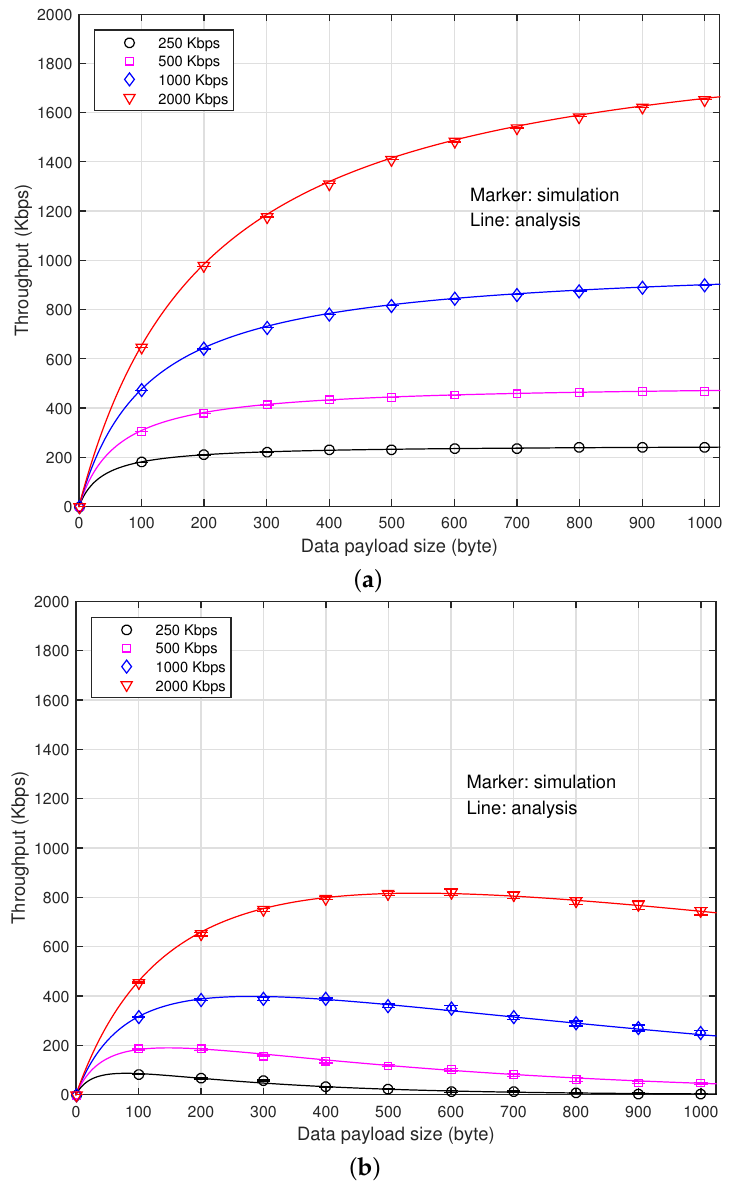
Figure 4. Throughput according to the payload size. ( a ) When ρ = 0; ( b ) When ρ =